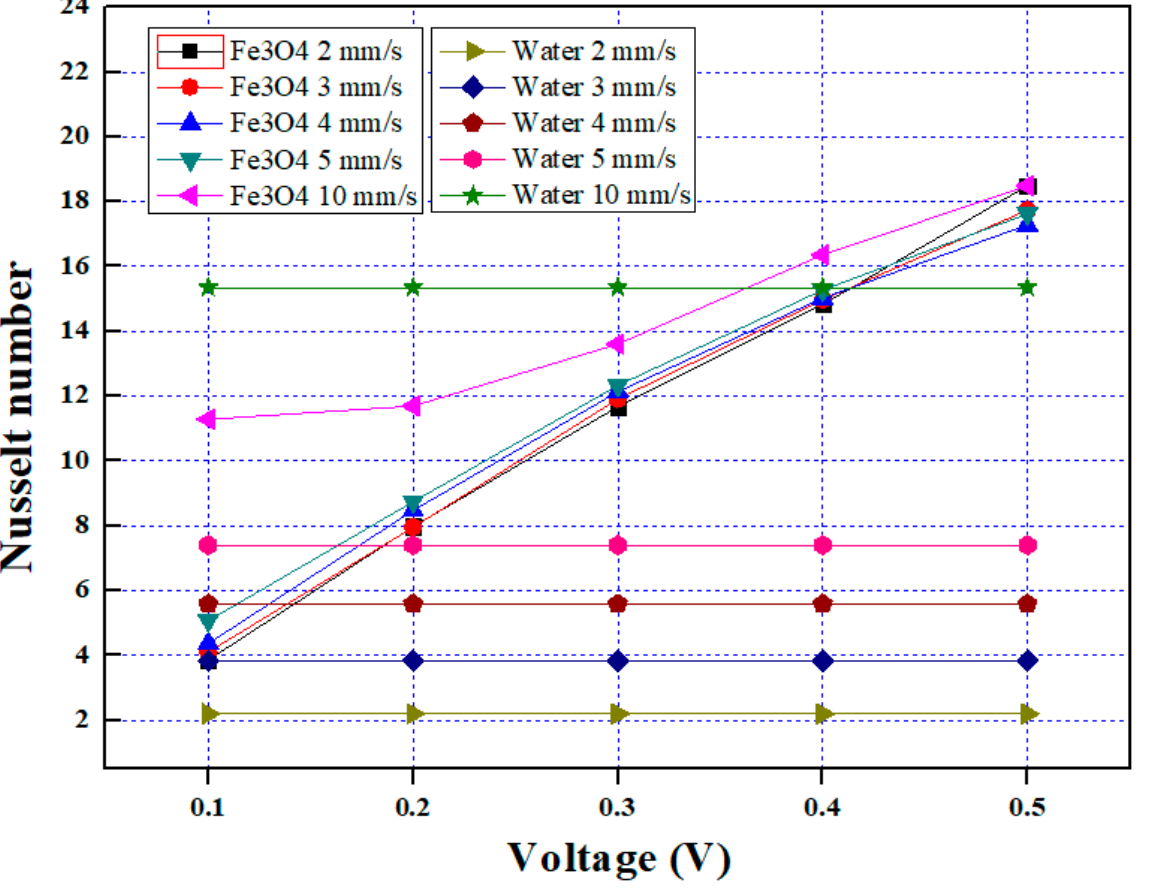
Figure 9. Effect of water and ferrofluid cooling with various conditions of inlet velocity and voltage on Nusselt